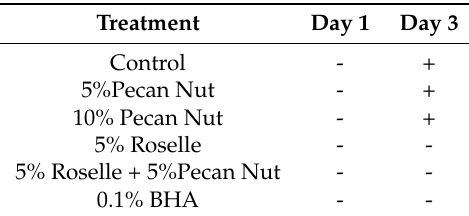
Table 2. Presence of mesophilic bacteria in the samples 1